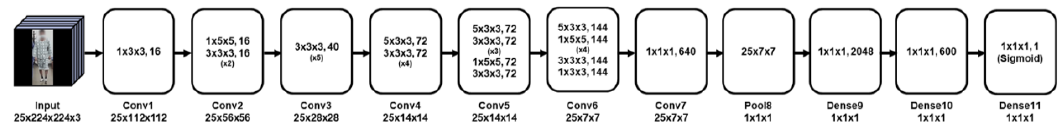
Figure 2. The 3D-CNN architecture for classification of dependence in ambulation (MoViNet-A2 structure). Conv, convolutional layer; Dense, dense layer; Pool, pooling layer. 177 The adapted model takes as input a 4D tensor (25 × 128 × 128 × 3; time × width × 178 height × color) constructed from patient-centered video segments with a uniform sam- 179 pling rate of 5 Hz, which allows us to optimize the size and quality of the video seg- 180 ments. Following the input layer, seven 3D convolutional blocks are connected in series.